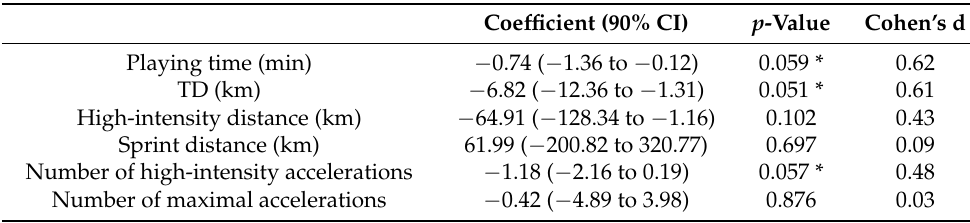
Table 2. Effects of playing time and physical performance on s-IgA differences calculated between 48-h post-match and 60-min before kick-off time